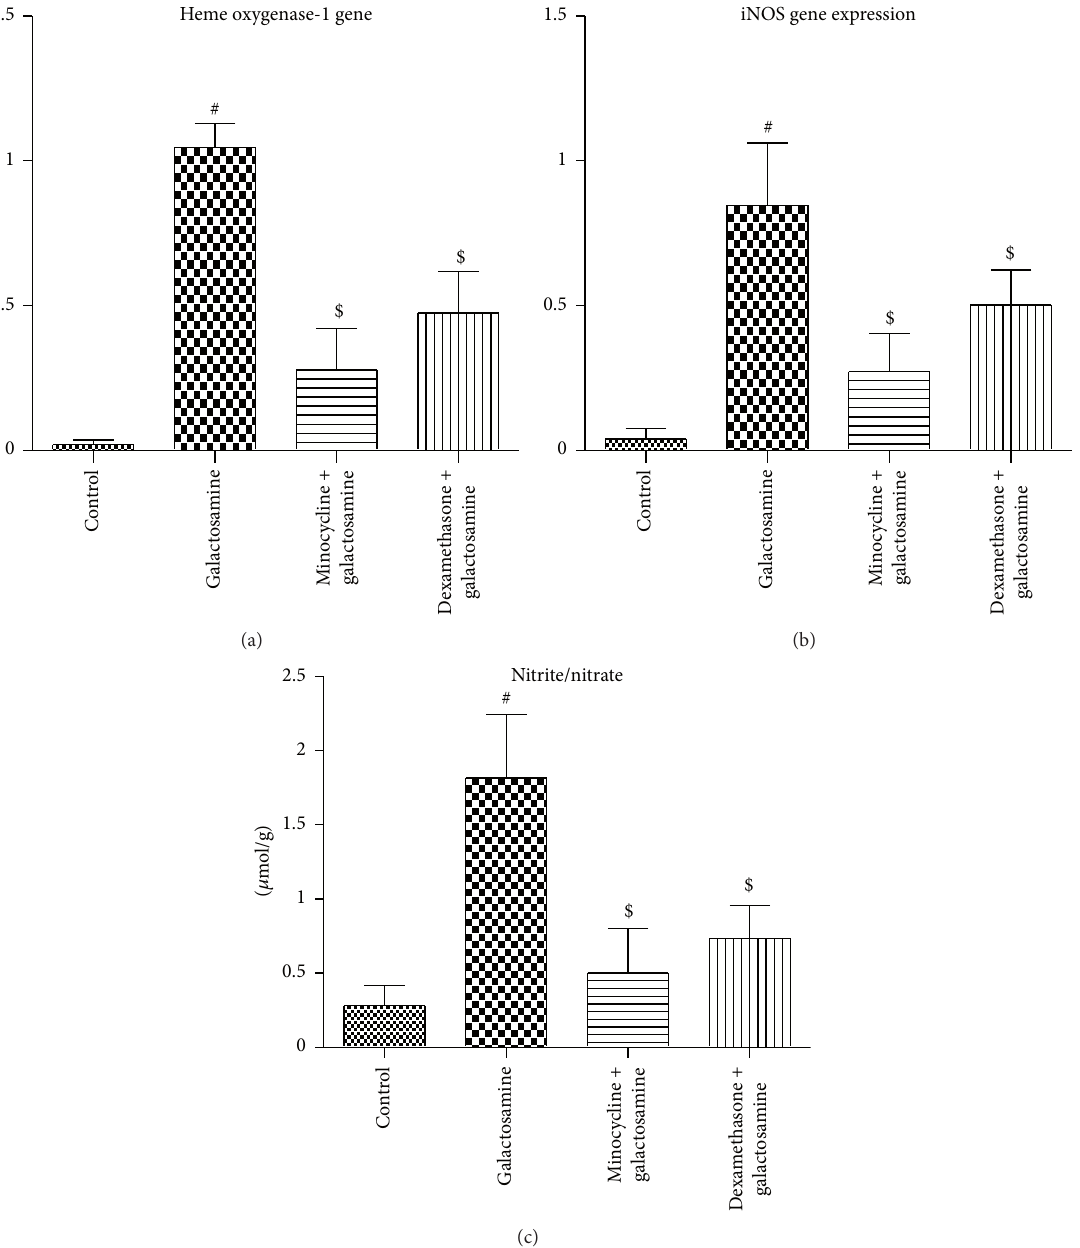
Figure 1: The effects of minocycline and dexamethasone on the oxidative/nitrosative stress associated with minimal hepatic encephalopathy. Both dexamethasone and minocycline ( 𝑛 = 6 per group) reduced the levels of heme oxygenase-1 gene expression (a), iNOS gene expression (b), and nitrite/nitrate ( 𝜇 mol/g) (c) in the brain tissue associated with acute liver injury. All values are expressed in means ± SD. # 𝑃 < 0.05 versus control; $ 𝑃 < 0.05 versus galactosamine treated